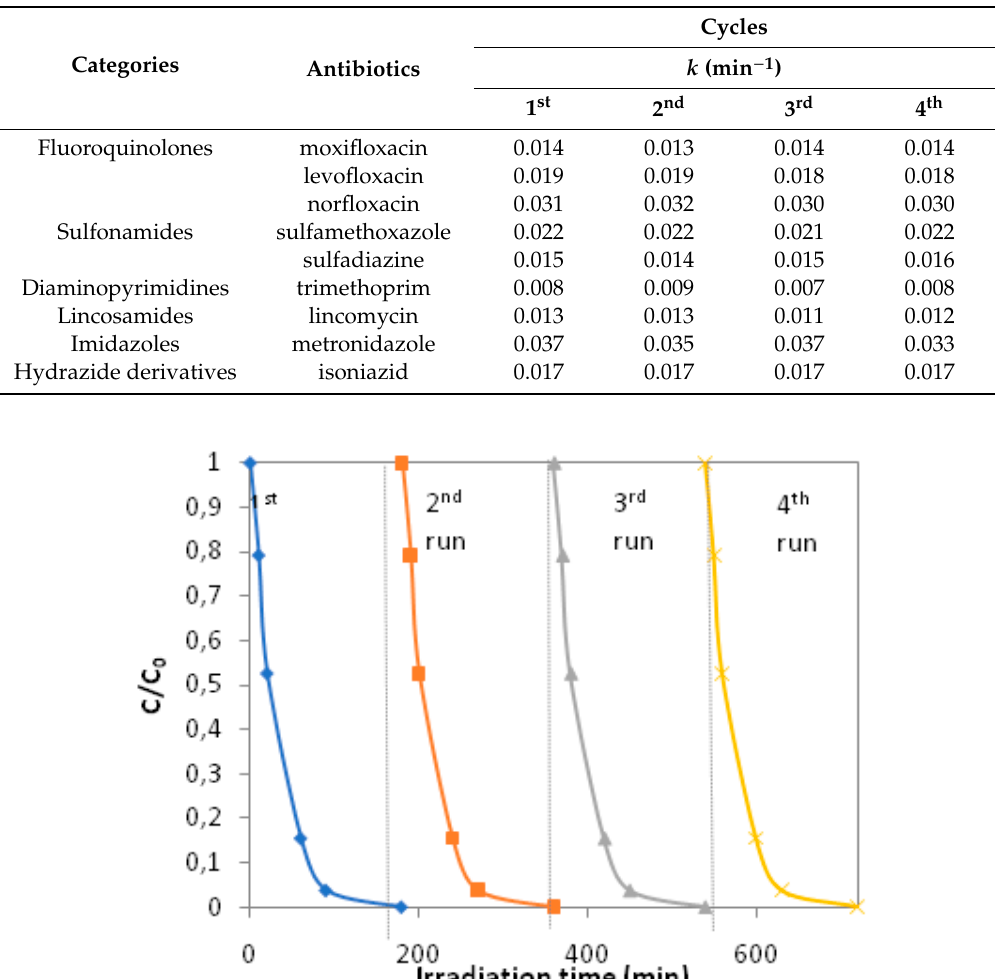
Table 3. E ff ect of reusability of the PLLA–GO–50 wt% TiO 2 films on the kinetic data of the photocatalytic